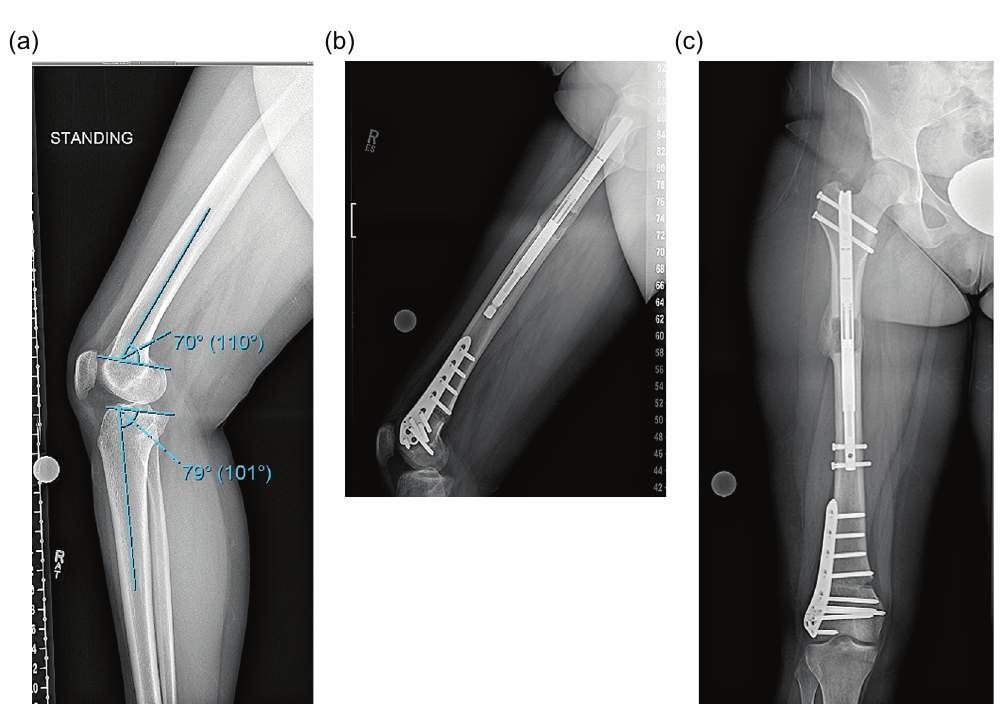
Figure 1. (a) This preop lateral radiograph shows a 13 (cid:3) flexion deformity of the distal femur. (b) Postop lateral shows a correction of the apex anterior deformity through an posterior opening wedge osteotomy stabilized with a plate and a proximal femoral lengthening with an ILN. (c) This far distal osteotomy would be difficult to control with an intramedullary